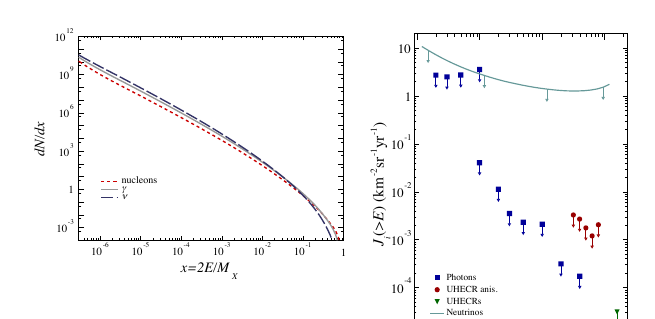
Figure1.Energyspectraofdecayby-productsofanSHDMparticle, basedonthehadronizationprocessdescribedin[37]. Themassof the X particleishere10 16 GeV.